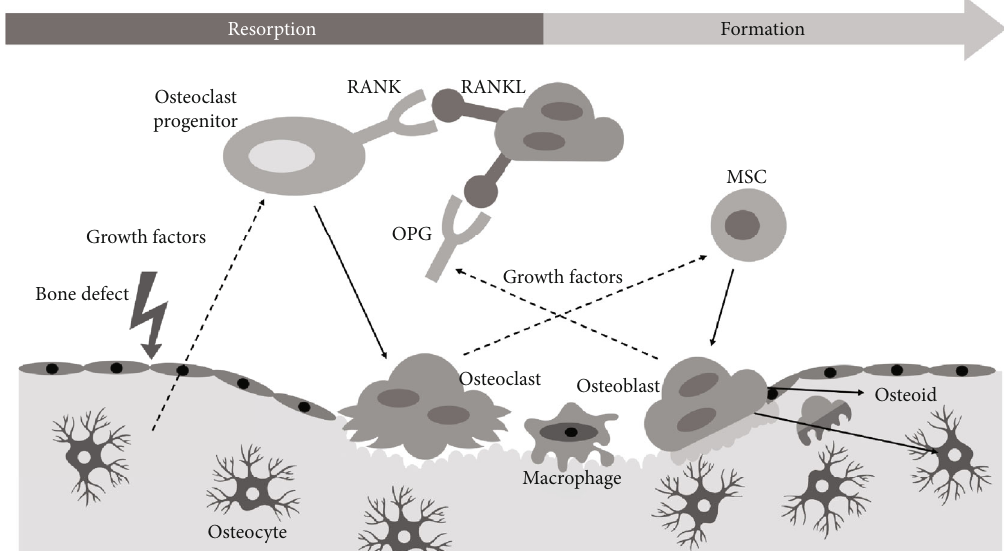
Figure 1: Schematic representation of the bone remodelling process. Solid lines indicate di ff erentiation, and dotted lines indicate stimulation. Osteocytes within bone tissue stimulate osteoclast progenitor cells to di ff erentiates into osteoclasts. Osteoblasts can also stimulate osteoclast progenitor cells through RANK/RANKL binding. Once the defective bone tissue is cleared, macrophage-like cells smooth the resorbed bone tissue. Before undergoing apoptosis, osteoclasts recruit osteoblasts for matrix deposition. Osteoblasts stimulate the release of osteoprotegerin (OPG) that acts as a soluble decoy and inhibits osteoclast di ff erentiation. Adapted from Wittkowske et al. [12], bone remodelling cycle, https://creativecommons.org/licenses/by/4.0/legalcode http://creativecommons.org/licenses/by/4.0/. MSC: mesenchymal stroma/stem cell; RANK: receptor activator of nuclear factor kappa- Β ; RANKL: receptor activator of nuclear factor kappa- Β ligand; OPG: osteoprotegerin.